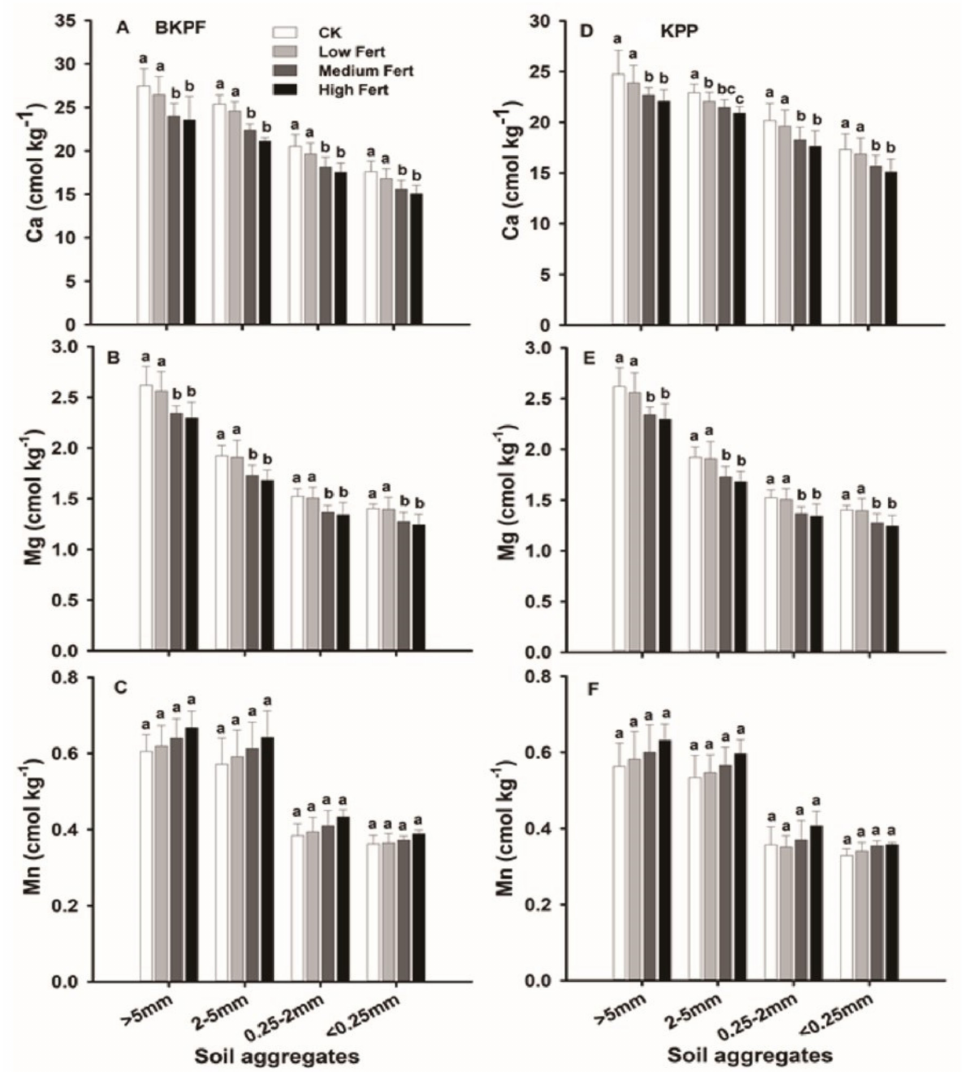
Figure 1. Calcium (Ca 2+ ) (cmol kg − 1 ) ( A , D ), magnesium (Mg 2+ ) (cmol kg − 1 ) ( B , E ), and manganese ion (Mn 2+ ) (cmol kg − 1 ) ( C , F ) at the control (C: no additional deposition; white bars) and after low NP: 05-g N m − 2 a − 1 + 05-g N m − 2 a − 1 ; light grey, medium NP: 15-g N m − 2 a − 1 + 10-g N m − 2 a − 1 ; dark grey, and high NP: 30-g N m − 2 a − 1 + 20-g N m − 2 a − 1 ; black fertilization in respective soil aggregates >5 mm, 2–5 mm, 0.25–2 mm, and <0.25 in three replications at 0–20 cm soil depth of broad-leaved Korean pine forest (BKPF) and Korean pine forest (KPP) in Northeast (NE) China. Significant differences between treatments are indicated by different lower-case letters (Tukey’s HSD post hoc; p < 0.05; mean ±